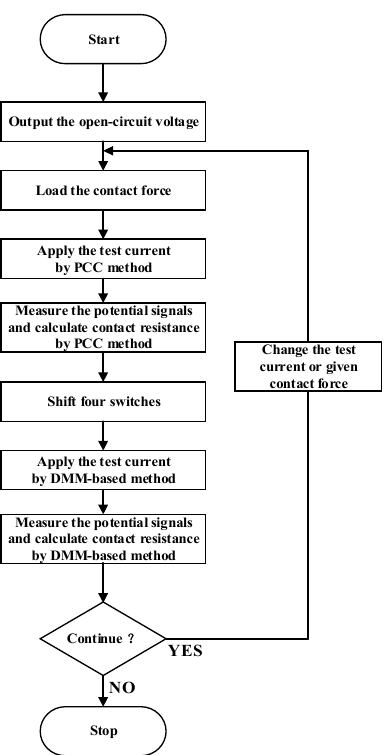
Figure 8. Experimental circuits for the DMM-based method and PCC method.